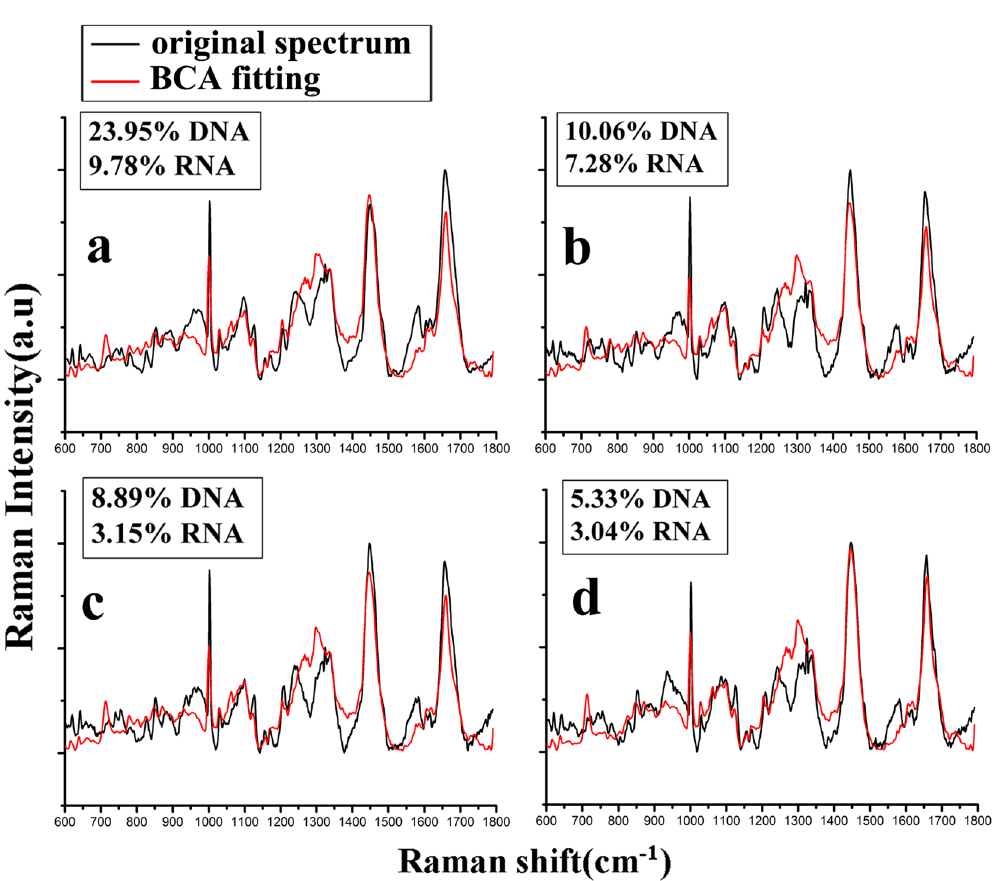
Figure 8. The relative contents of DNA and RNA of Jurkat cells achieved by BCA fitting of Raman spectra, in which Jurkat cells were treated with DNR-induced apoptosis ( a ) without treatment; ( b )in the early stage; ( c ) in middle stage; ( d ) in late